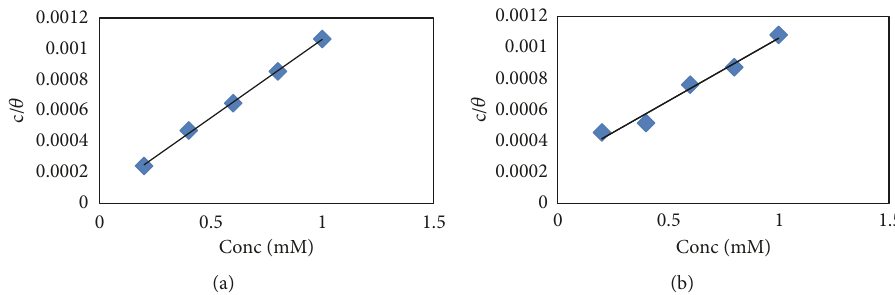
Figure 4: (a) Langmuir adsorption isotherm of DmChDp on MS in 1M HCl at 28 ∘ C. (b) Langmuir adsorption isotherm of DmChDp on MS in 0.5 M H 2 SO 4. at 28 ∘ C.